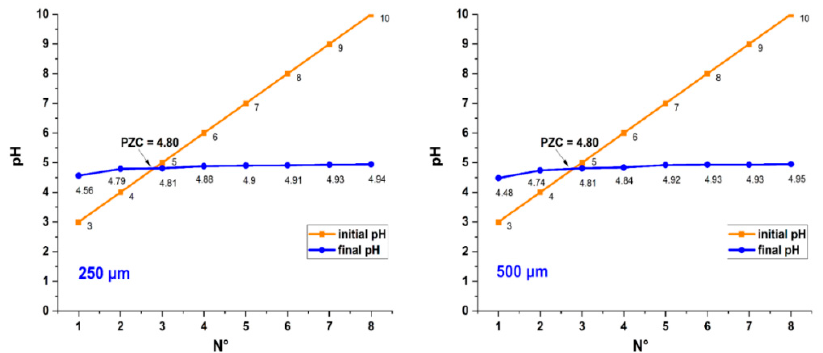
Figure 3. Point of zero charge in the fractions of 250 and 500 µm.